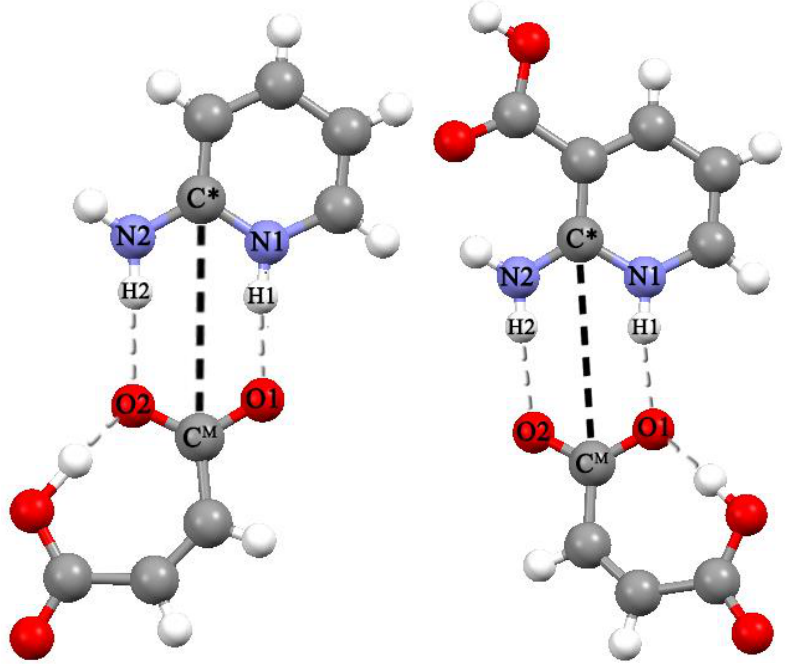
Scheme 1. Structures of 2-aminopyridine ( a ), 2-aminonicotinic acid ( b ), and maleic acid ( c ). The red, blue, gray and white circles represent oxygen, nitrogen, carbon, and hydrogen atoms, respectively.